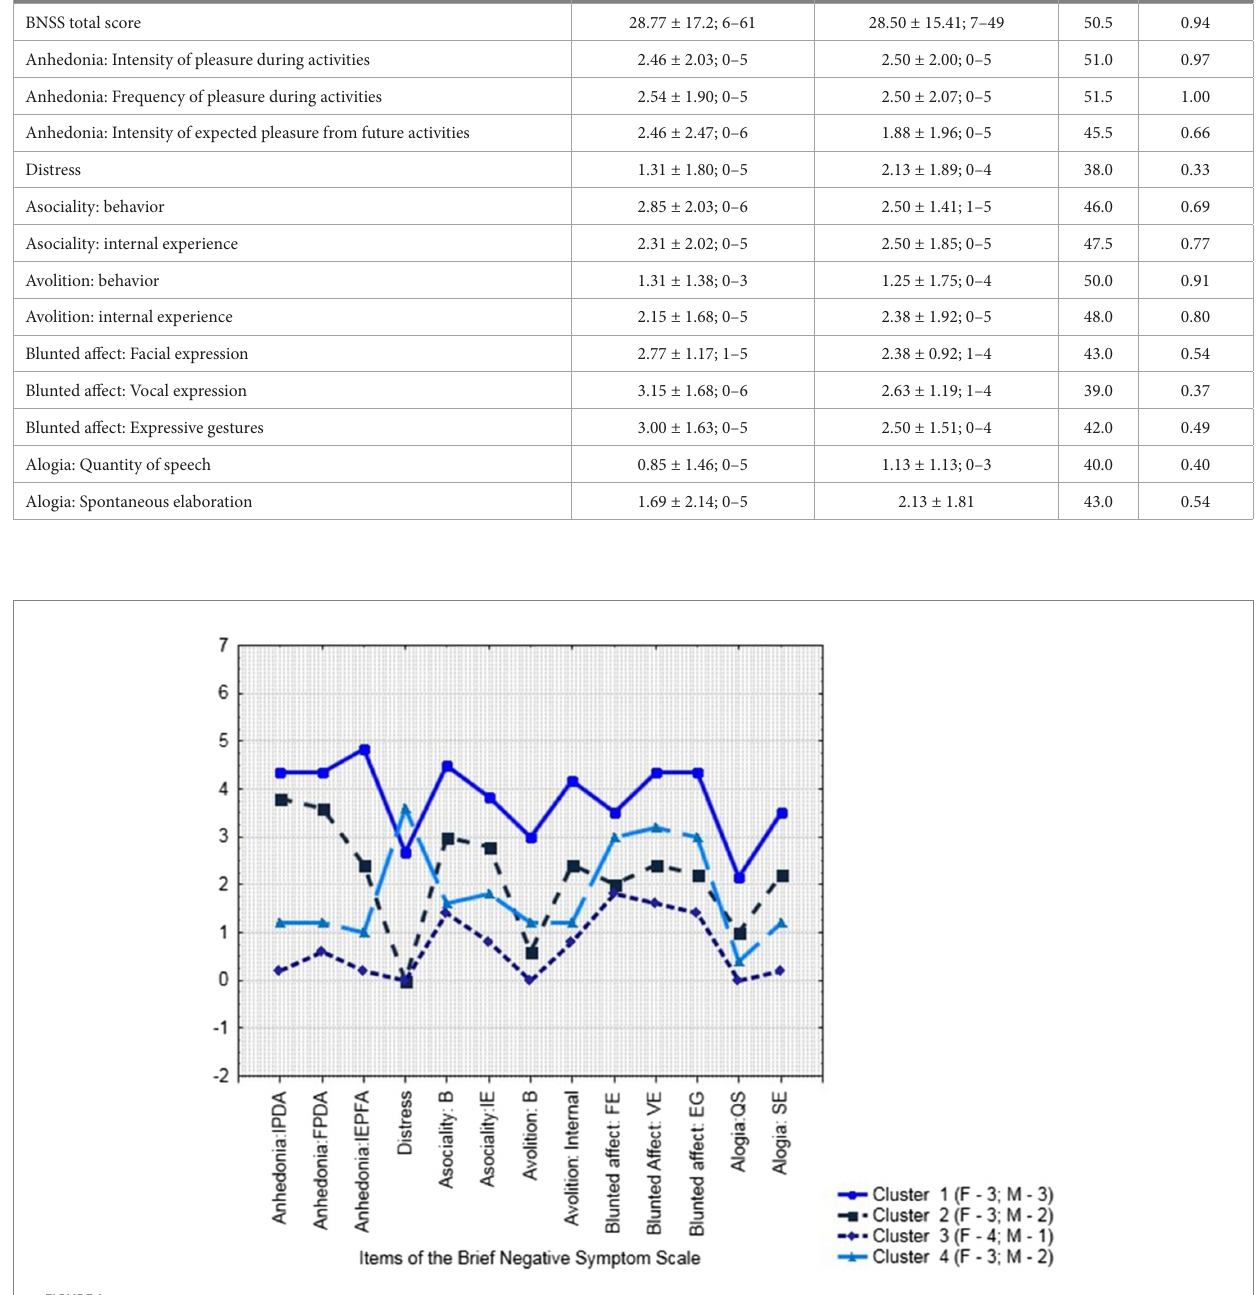
FIGURE 1 Cluster analysis of BNSS results ( N = 21: Females–13; Males–8): Plot of